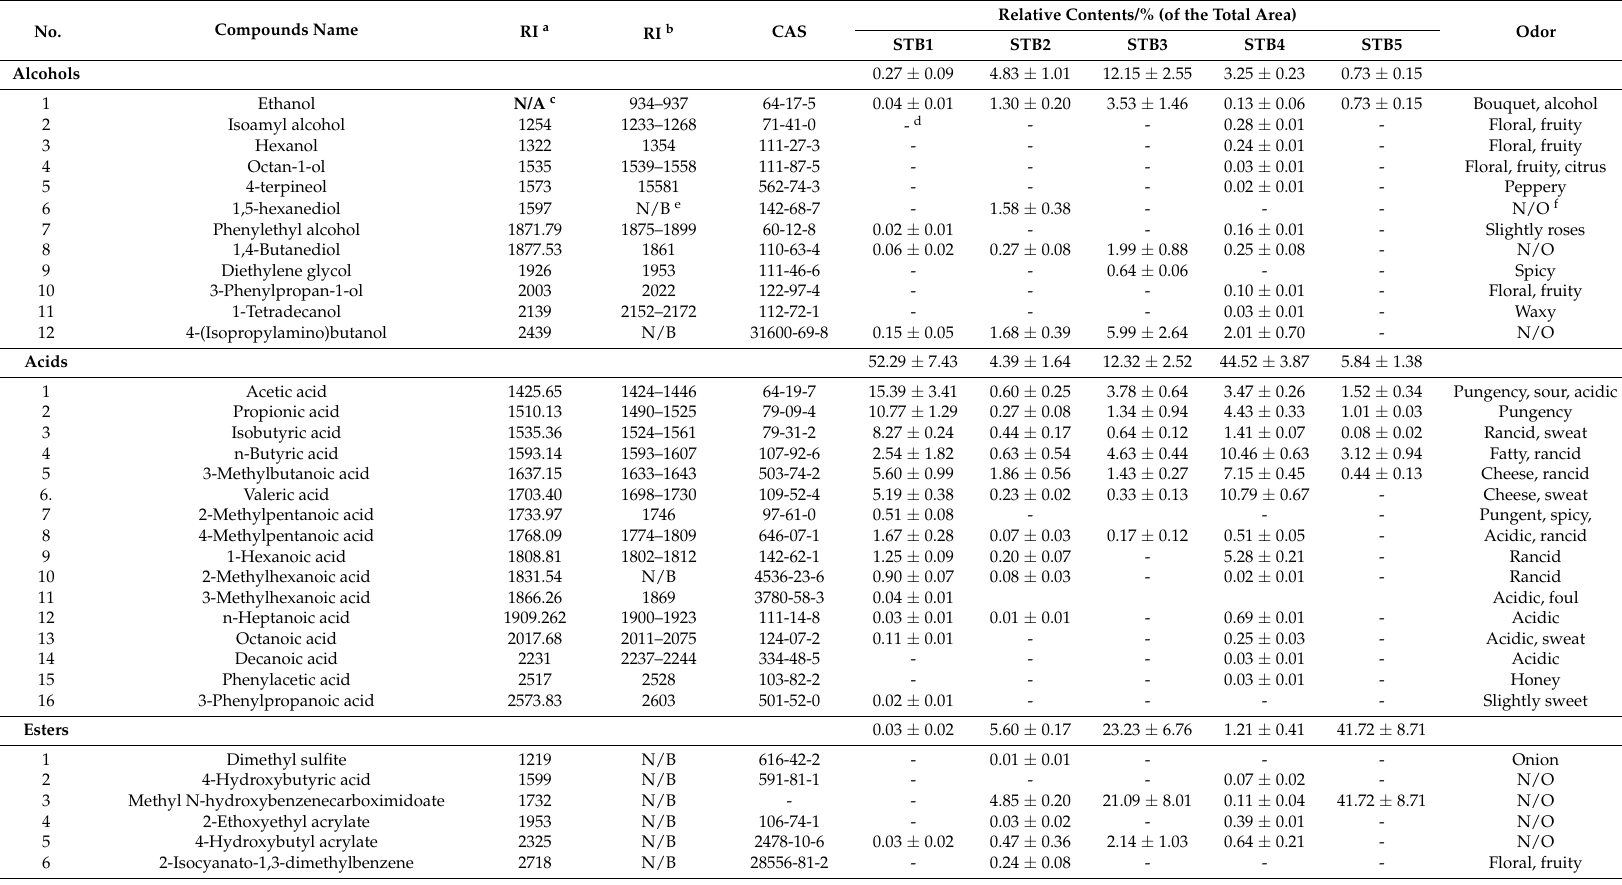
Table 2. Relative contents and flavor characteristics of volatile compounds in five stink tofu